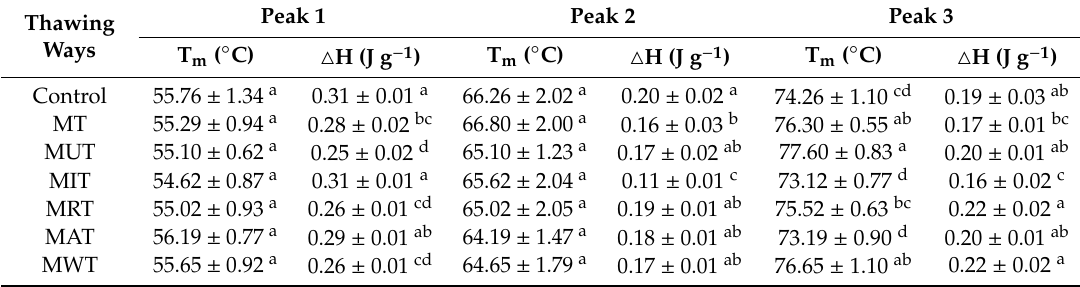
MT: Microwave thawing (100 W); MUT: Microwave combined with ultrasonic thawing; MIT: Microwave combined with 35 ◦ C water immersion thawing; MRT: Microwave combined with 4 ◦ C refrigeration thawing; MAT: Microwave combined with air convection thawing; MWT: Microwave combined with running water thawing. Data are means ± SE. a–d values in the same row followed by di ff erent letters are significantly di ff erent according to Duncan’s multiple range test ( p <